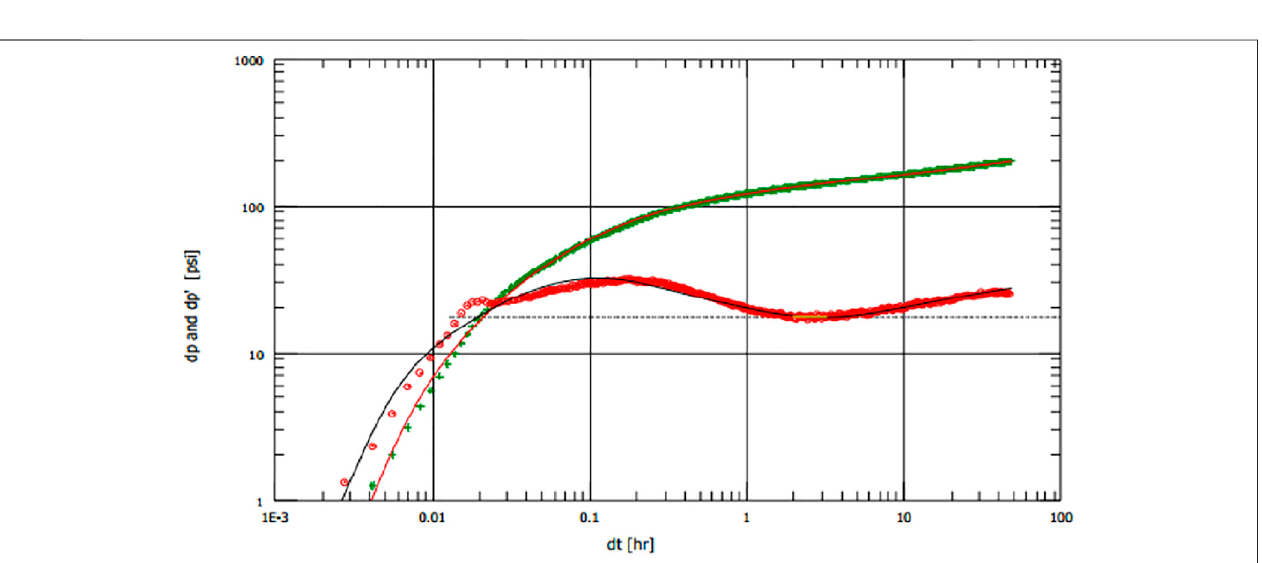
FIGURE 4 | The log-log curve of P1.